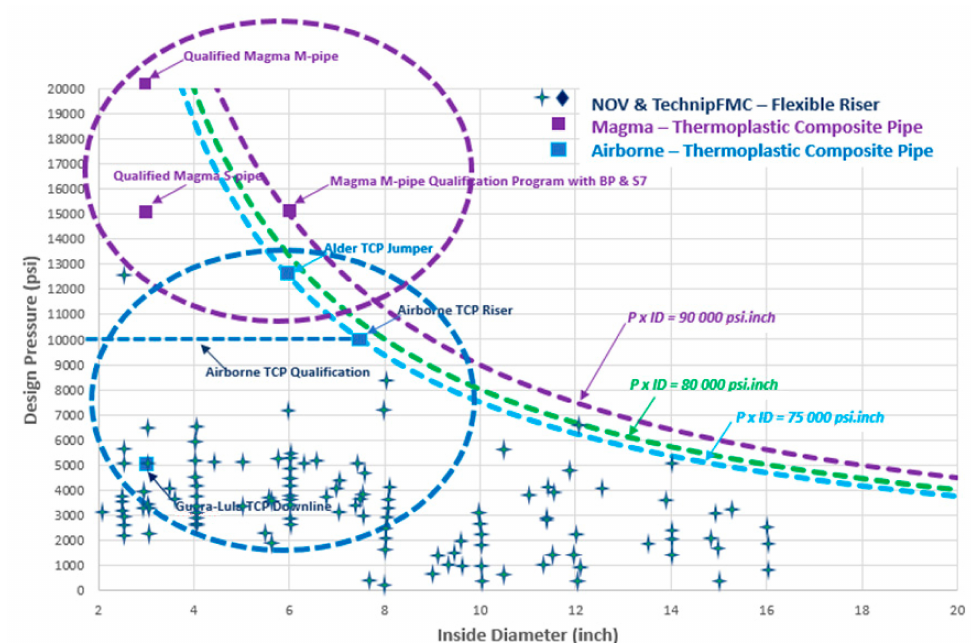
Figure 6. Qualification roadmap of flexible pipes, TCP pipes and composite risers in industry, showing manufacturers including NOV & Technip FMC, Airborne Oil&Gas and Magma Global. (Source: [217,276]; Data extracted from [277]; Courtesy: Leviticus Subsea. Permission to use this image was obtained from Lamacchia